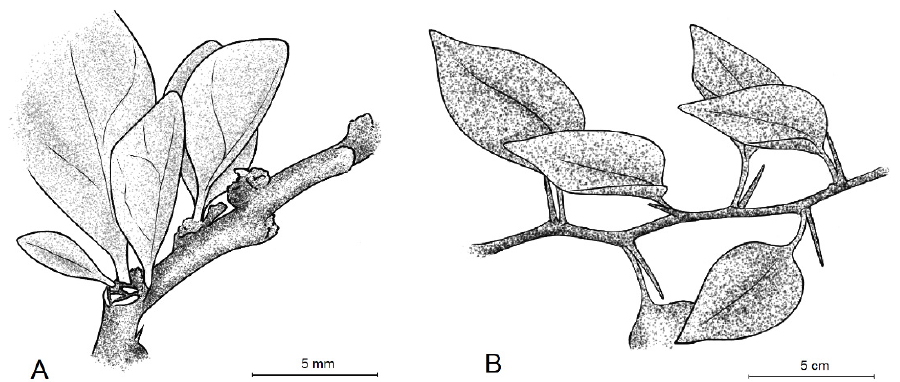
Figure 7. Leaf arrangement of Bougainvillea berberidifolia ( A ) and Bougainvillea stipitata ( B ). (Illustrated by Eingel Cannerie Jaramillo)